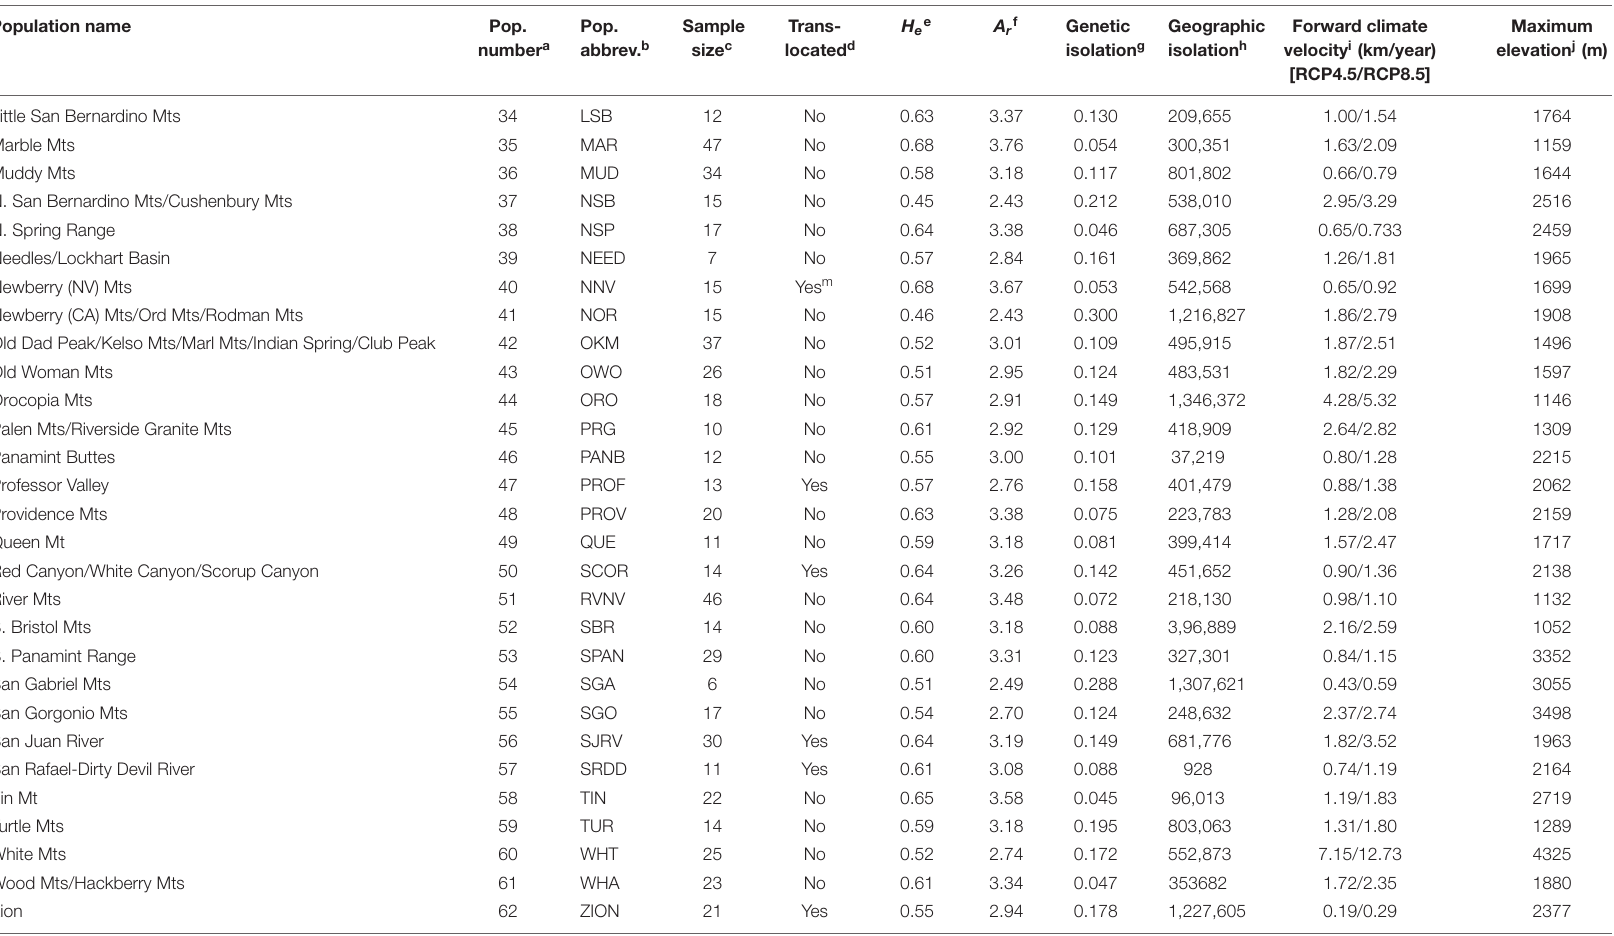
a Population number used in Figure 1 . b Population abbreviation used in Figures 5 – 9 . c Number of unique genotypes (i.e., individuals) sampled in population. d Indicates whether population has received individuals translocated from outside populations; populations that received only small numbers of translocated individuals that may have had only minor genetic influence are flagged. e Allelic richness, a measure of population genetic diversity. f Expected heterozygosity, a measure of population genetic diversity. g Mean of pairwise F ST values with three nearest neighbors, as measured by effective distances along least-cost paths between habitat polygon boundaries using a landscape resistance model derived from Creech et al. (2017). h Mean of effective distances to three nearest neighbors, as measured along least-cost paths between habitat polygon boundaries using a landscape resistance model derived from Creech et al. (2017). i Mean of forward climate velocity (km/year) values from AdaptWest Project (2015) for pixels within each habitat polygon; higher values are associated with greater exposure to climate change. Values are shown for two emissions scenarios, RCP4.5 and RCP8.5. j Maximum elevation within habitat polygon. k Minor translocation of 5 sheep from Old Dad Peak in 1992. l Minor translocation of 16 sheep from Muddy Mts. in 1994. m Single individual translocated from River Mts. in